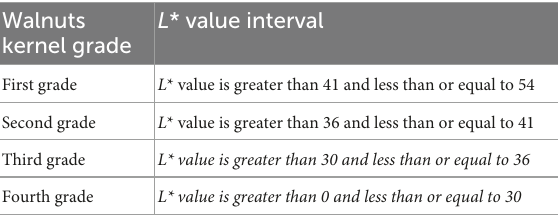
TABLE 1 Ranges for walnut kernel